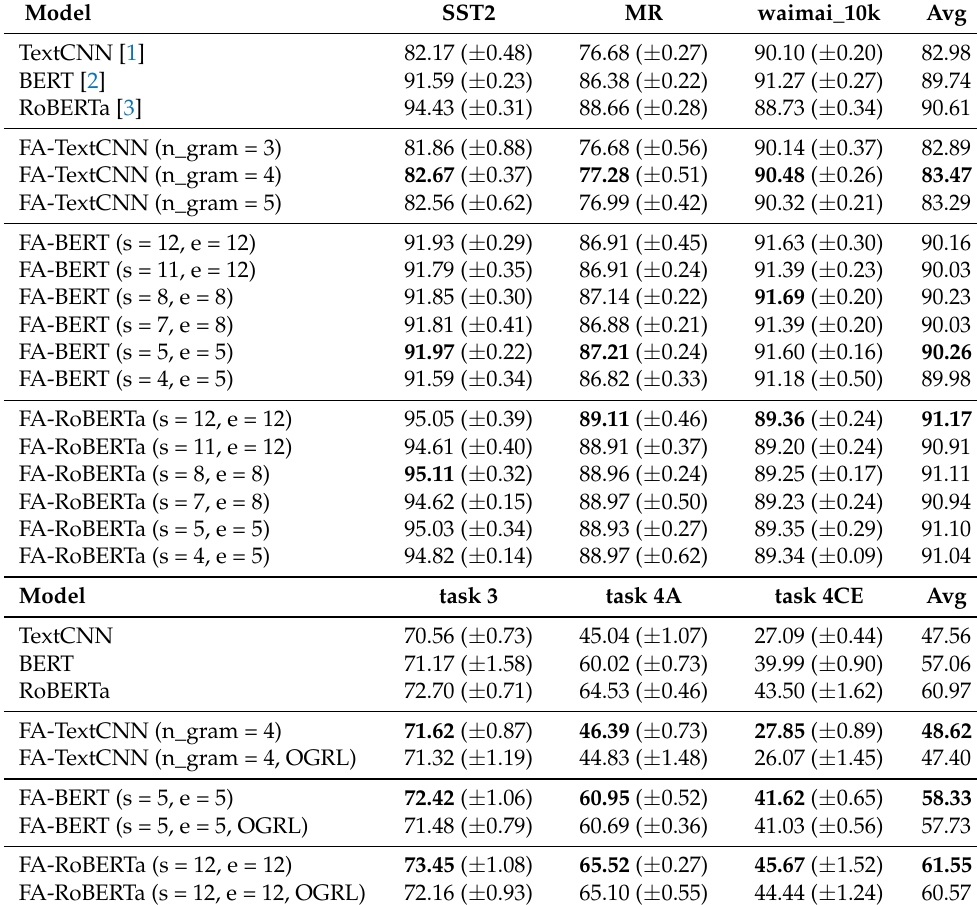
Table 3. The contrast between benchmarks and our models is shown in this table. The results of BERT-based models are conducted under the five seeds, including benchmarks and FA-Nets. Task 3 means SemEval-2018 task 3, task 4A means Sem-2017 task 4A, and task 4CE means Sem-2017 task 4CE. In the TextCNN model, n_gram=n means the filter is set to n when initializing the A-Net’s convolution layer. In the BERT and RoBERTa models, s means the s th F-Net’s encoder is copied as the first encoder at A-Net, and e means the e th F-Net’s encoder is copied as the last encoder at A-Net. The input of A-Net is the output of the ( s − 1 ) th encoder of F-Net. Furthermore, the “OGRL” means that we removed the GRL in the A-Net. The Avg is the average result from the sentiment analysis and sarcasm detection datasets. The best results in our implementation are marked with bold